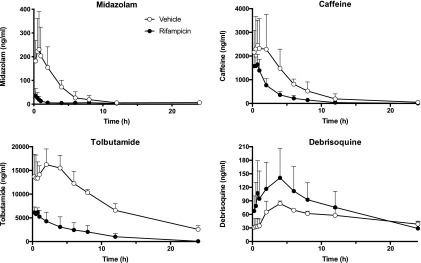
Effect of rifampicin on the pharmacokinetics of human P450 substrates. Adult female 8HUM mice (n = 3 or 4) were treated intraperitoneally with either vehicle (corn-oil; open circles) or rifampicin (closed circles) at 10 mg/kg, daily for 2 days, and on day 3 were administered by oral gavage a cassette comprising midazolam, caffeine, tolbutamide, and debrisoquine, and PK profiling was carried out as described in Materials and Methods. Data shown are mean ± S.D.